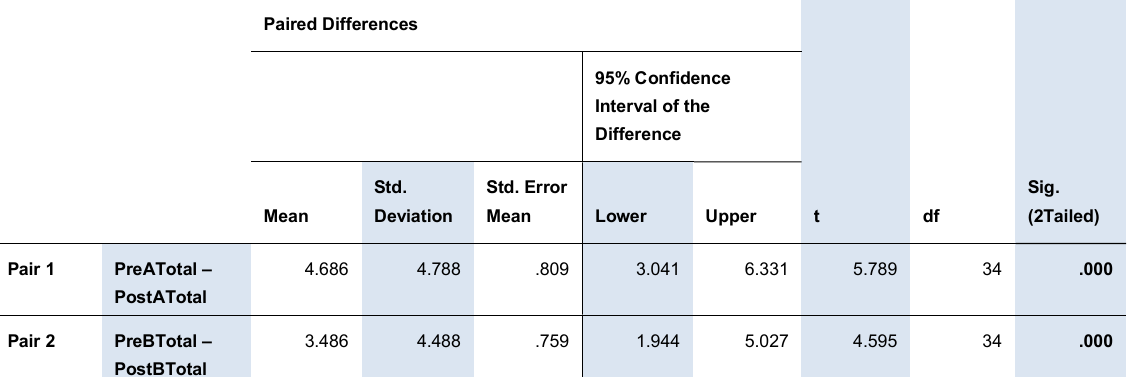
Table 3: Paired Samples